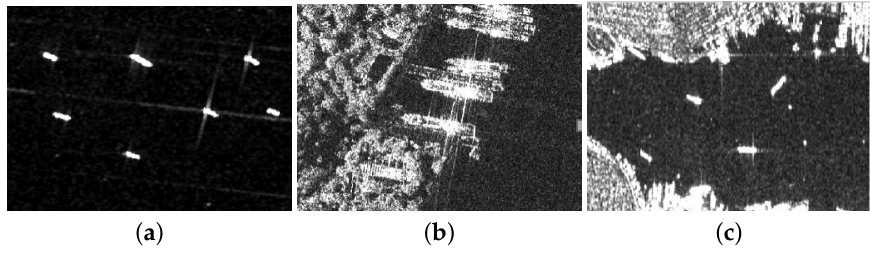
Figure 12. Some samples from SSDD. ( a ) Simple background ( b ) complex background ( c ) nearshore